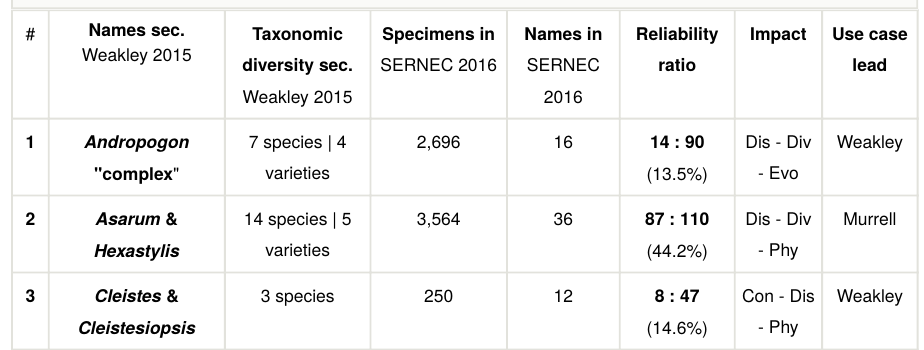
Overview of 12 use cases. Headers: valid names sec. Weakley 2015; species- and variety-level diversity sec. Weakley 2015; number of SERNEC specimens (August, 2016); number of corresponding SERNEC names; reliability ratio from Weakley's RCC–5 data (see Table 1: bold italics versus regular font cells), showing reliable vs. unreliable names and the percentage of reliable names; biological signi fi cance for di ff erential concept resolution ( Con servation, Cul tivars, Dis tribution, Div ersity, Eco logy, Evo lution, Exo tics, G lobal C hange B iology, H istorical B io G eography, Phy logeny, Pol lination); and leading SERNEC